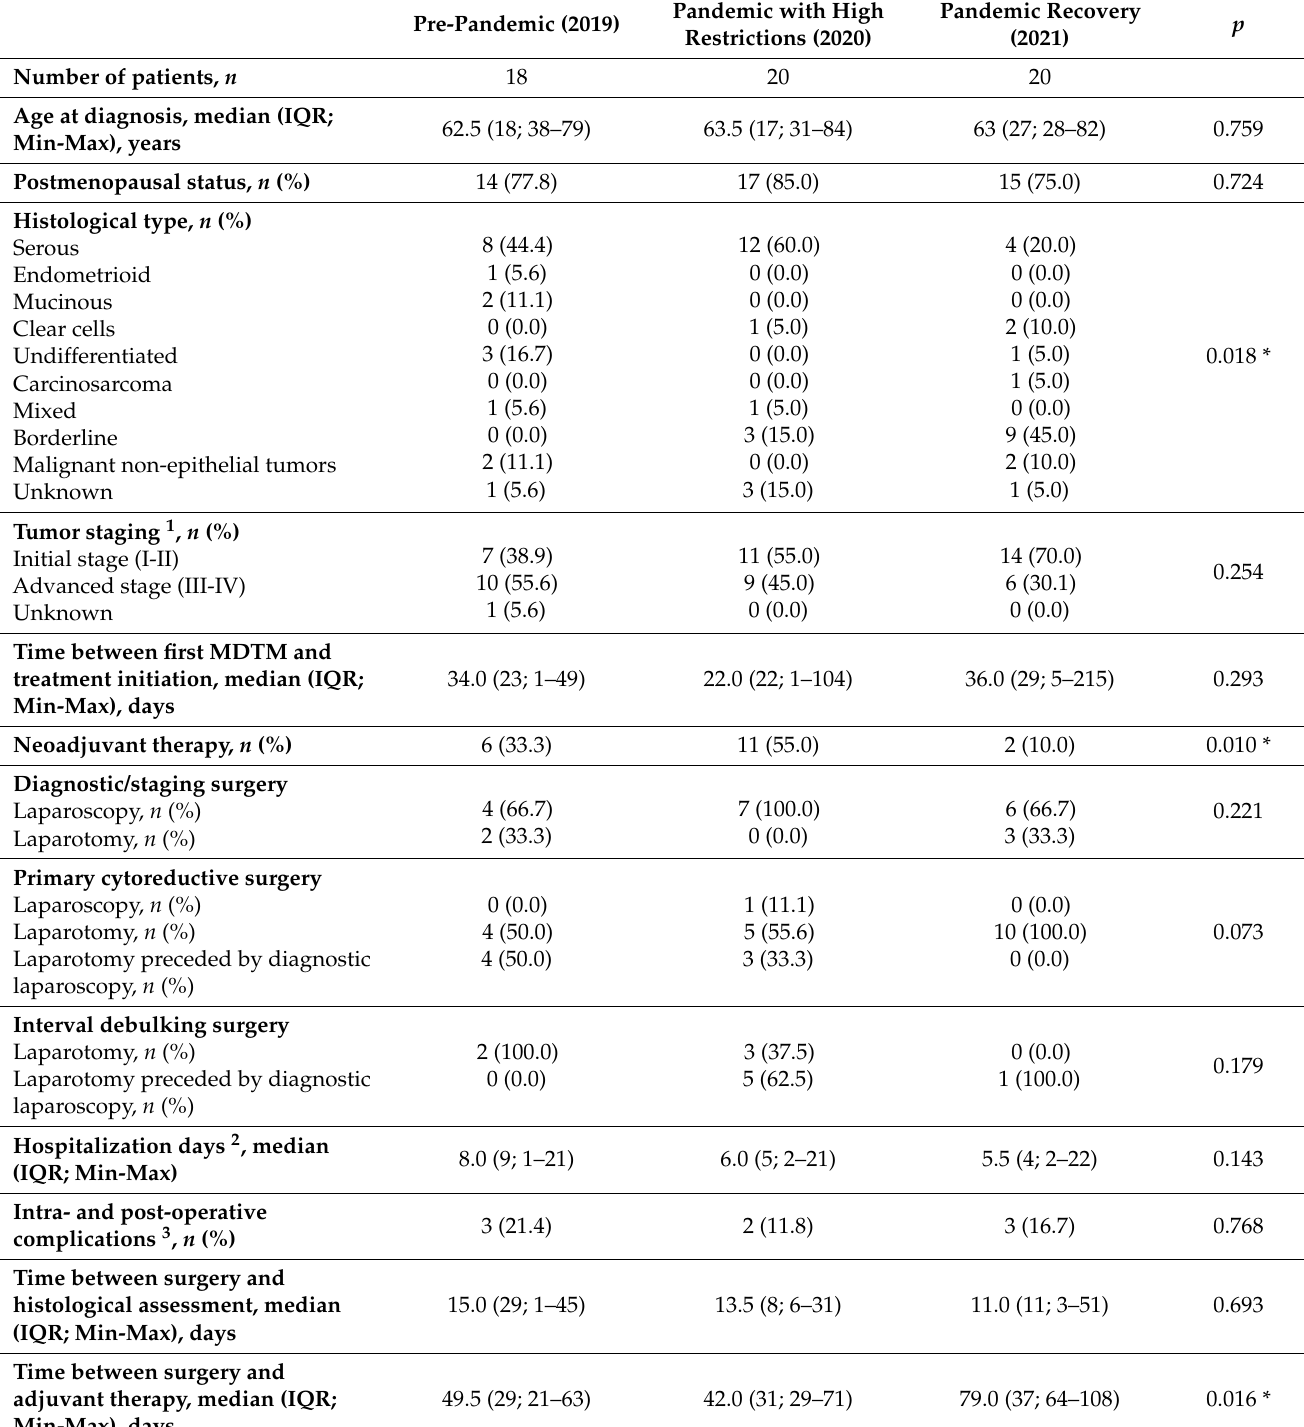
Table 2. Epidemiological, clinical and pathological patterns of patients diagnosed with ovarian, fallopian tube and primary peritoneal cancer ( n =